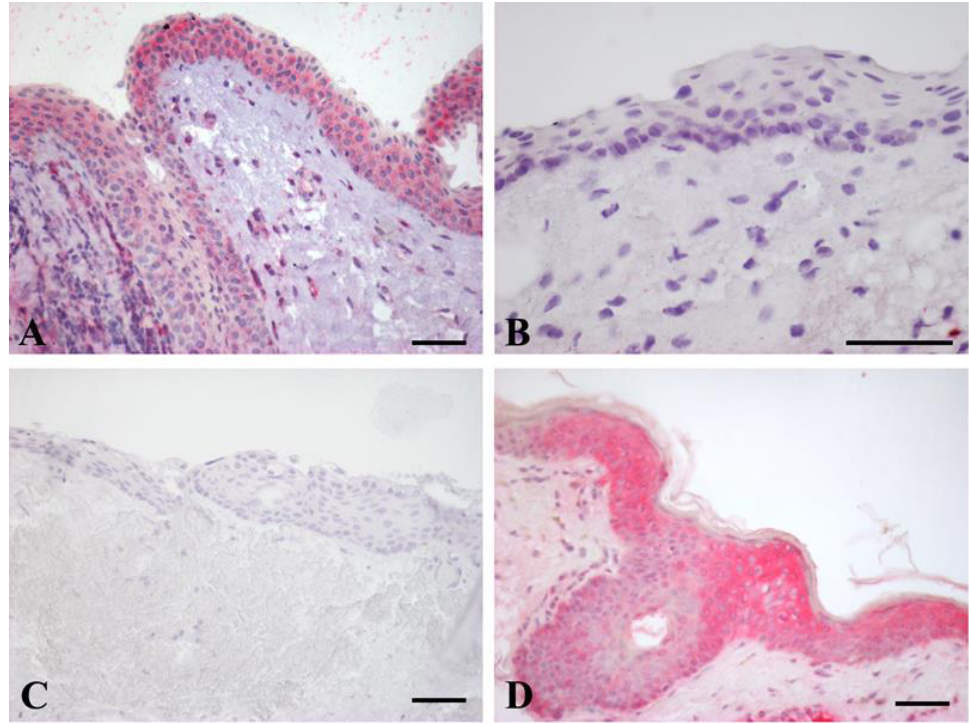
Figure 2. IGF-2 IHC expression: ( A ) pterygium; ( B ) conjunctiva; ( C ) pterygium, negative control ( D ) human skin, positive control. Counterstained with Carazzi hematoxylin. ( A – D ) Scale bar= 25 µm.